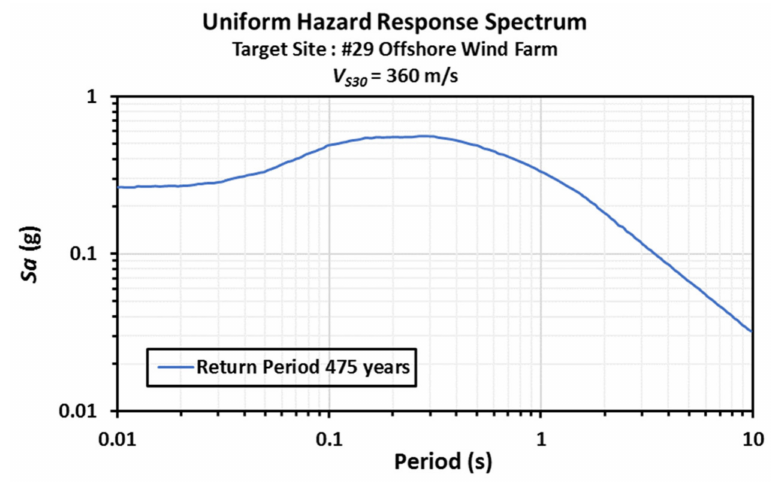
Figure 3. Response spectra at #29 offshore wind farm engineering